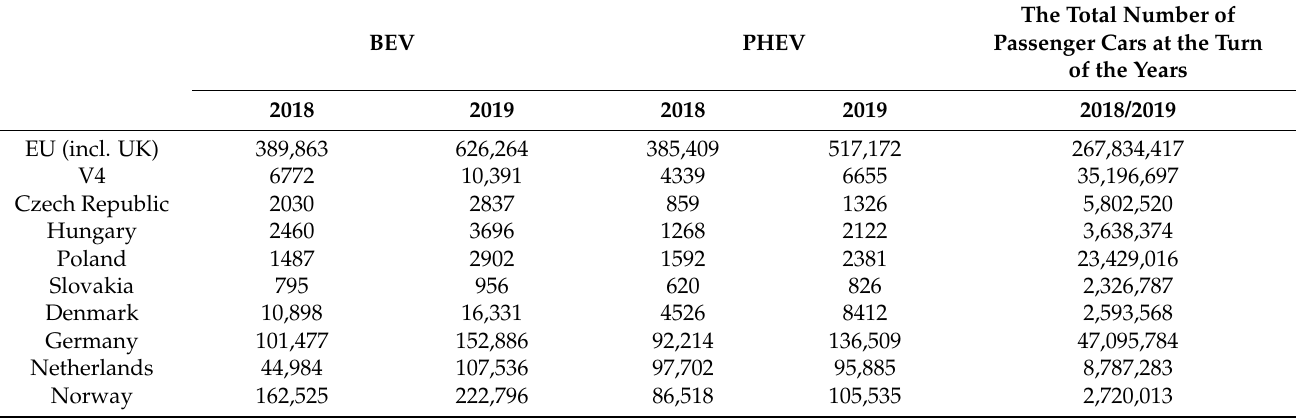
The Total Number of Passenger Cars at the Turn of the Years